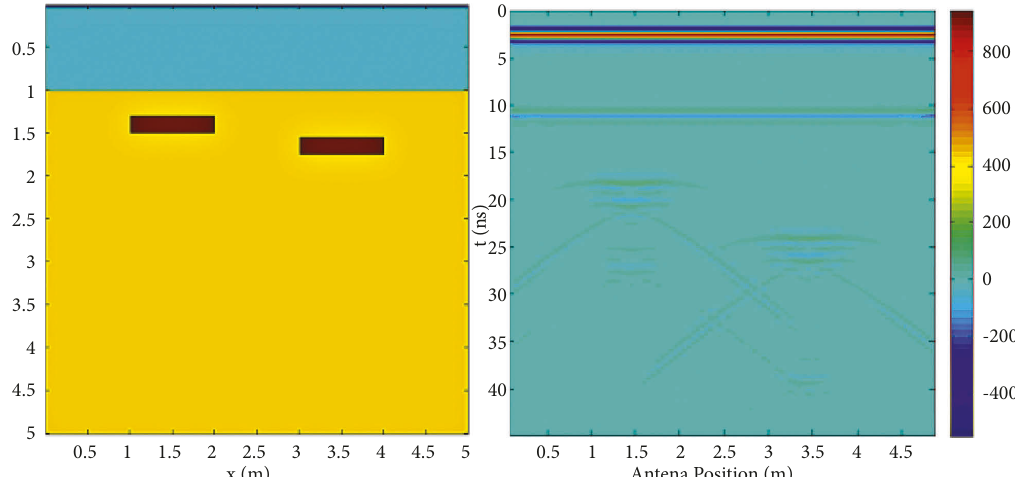
Figure 3: Block heavy metal pollution model and forward modeling results, left image x(m), right image antenna position (m).